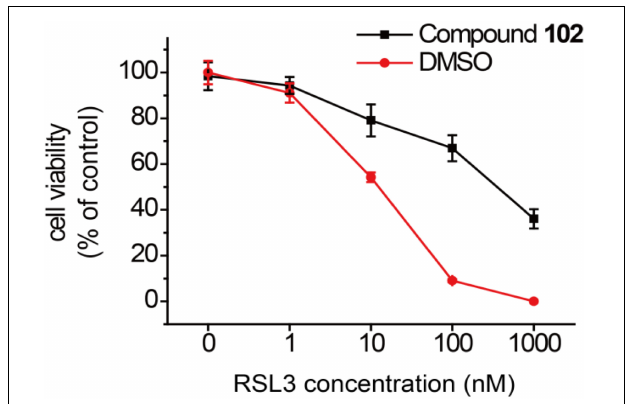
FIGURE 9 | Prevention of RSL3-induced ferroptosis by GPX4 activator compound 102 in HT-1080 cells. Death suppression by compound 102 (125 µ M) with increasing RSL3 concentrations. Data shown represent the mean ± standard error of mean (SEM; n = 5).